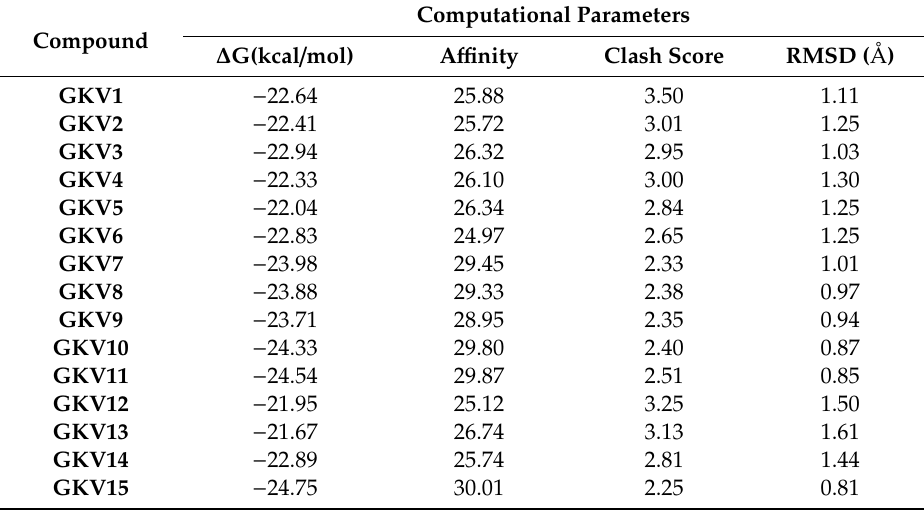
Table 2. Molecular docking results of the (5-(substituted phenyl)-2-methyl-2 H -1,2,3-triazol-4-yl) (4-substitutedphenyl / thiophenyl) methanone analogues of GVK1–15.